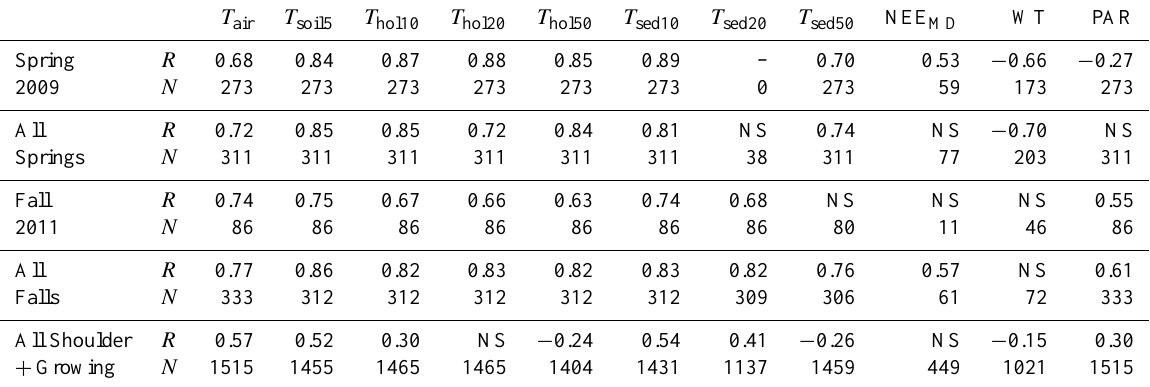
Table 2. Pearson’s product–moment correlation analysis for 30min averaged F CH data and environmental variables. Correlations are shown 4 for spring of 2009 (DOY 150–190), all springs (DOY 150–190, 2008–2011), fall of 2011 (DOY 260–320), all falls (DOY 260–320, 2008– 2011) and all shoulder + growing seasons’ (DOY 150–320, 2008–2011) data. NS represents P > 0.0001 (statistically insignificant) and